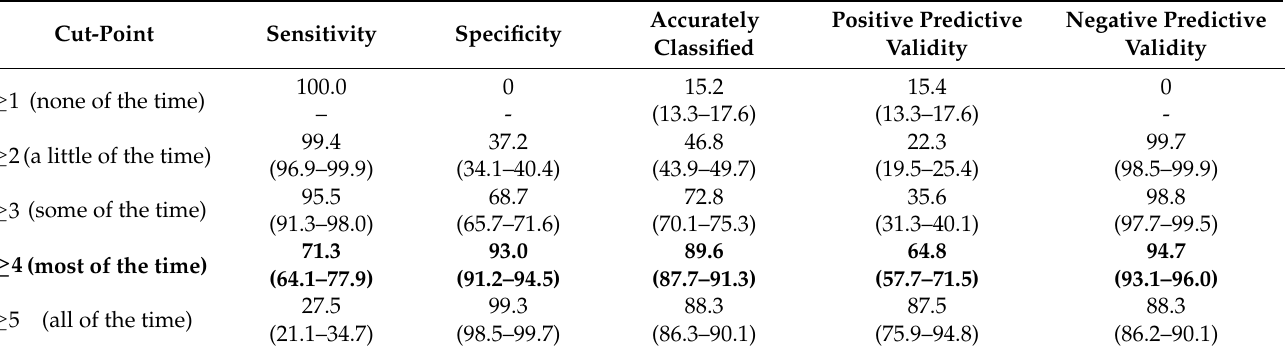
Table 2. Measures of correspondence between the binary measure of distress from the K6 and the TTPN distress item. Cut-point